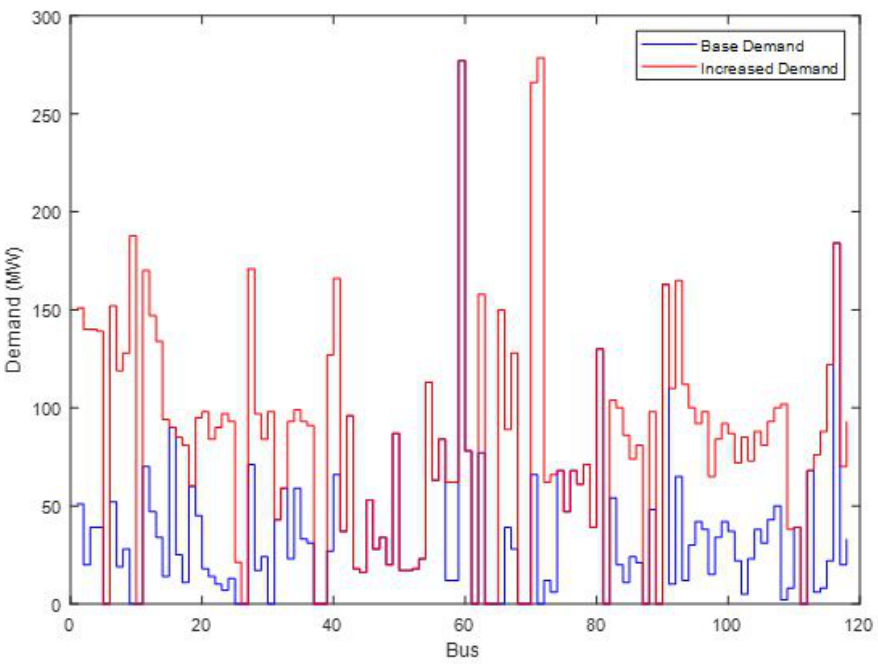
Figure 9. The 118-bus system’s load profile in base and increased demand scenarios.